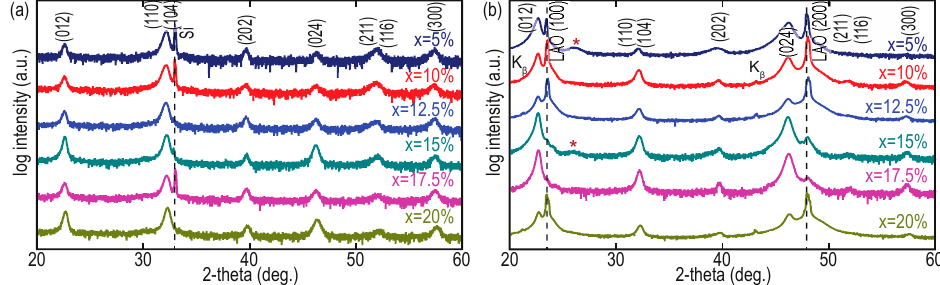
Figure A1. ( a ) X-ray diffraction (XRD) patterns of (Bi 1 − x Pr x )(Fe 0.95 Mn 0.05 )O 3 (BPFMO) thin films deposited on Si substrates, in which the Bragg diffractions of BPFMO are indexed using a rhombohedral structure. There is no secondary phase observed in the BPFMO thin films with Pr substitution concentrations from x = 0.05 to x = 0.20. ( b ) XRD patterns of (Bi 1 − x Pr x )(Fe 0.95 Mn 0.05 )O 3 thin films deposited on LaAlO 3 (100) single-crystalline substrates. The BPFMO thin films exhibit a preferential (012) orientation.